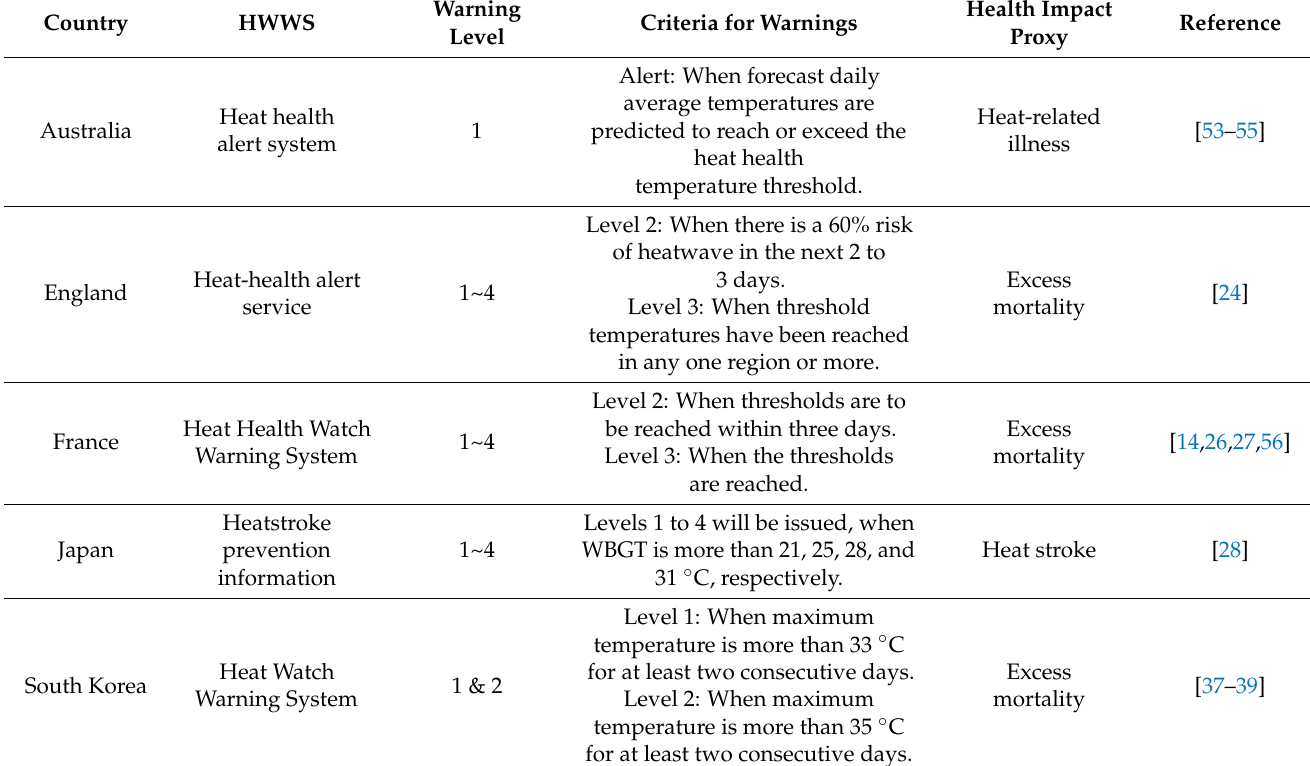
Table A1. Classification of levels and health impact proxies in heatwave warning systems (HWWS).